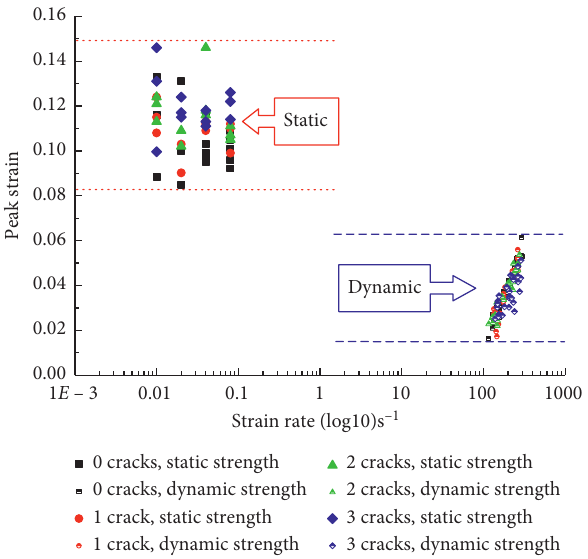
Figure 8: Peak strain of frozen silty soil with various prefabricated crack numbers and strain